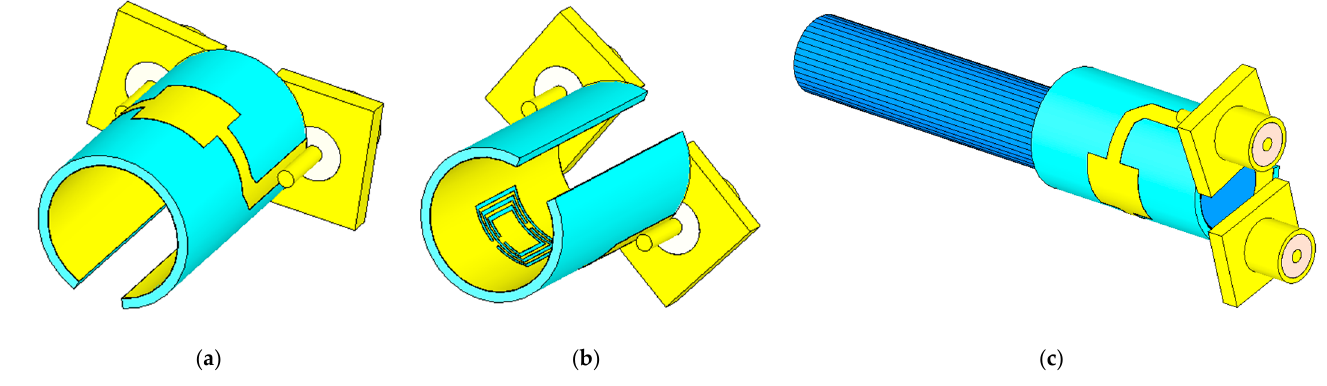
Figure 2. 3D view of the proposed sensor: ( a ) upper side view; ( b ) inner side view; ( c ) final structure with embedded glass tube. Table 1. Geometrical parameters of the proposed sensor structure.